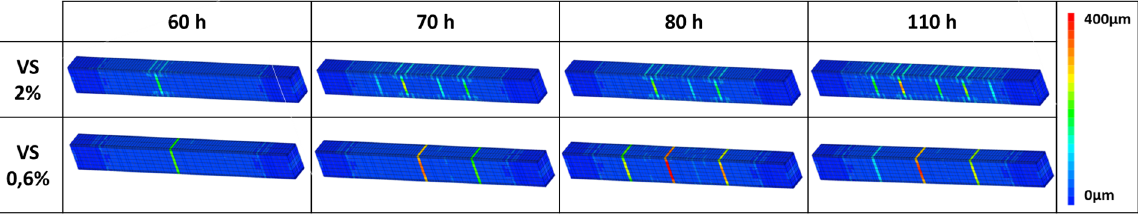
Figure 13. Effect of reinforcement ratio on cracking pattern.